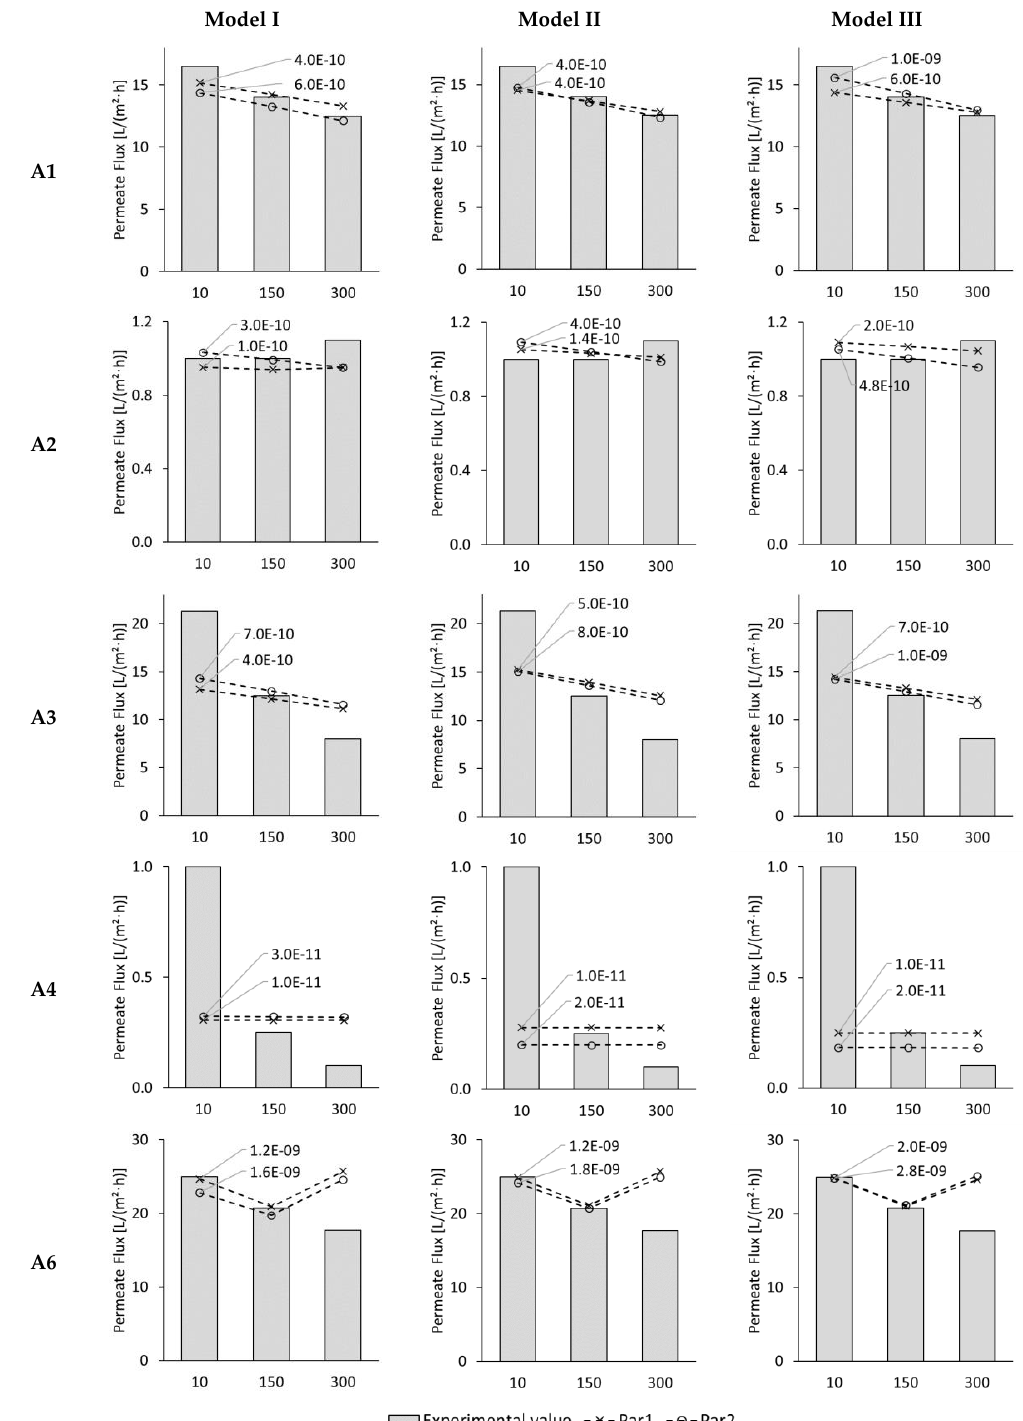
Figure 3. ALFS permeate fluxes of test series A1, A2, A3, A4, and A6 for 10, 150, and 300 min test time from experiments (columns) and Model I, Model II, and Model III with membrane parameter set Par1 (dashed line with crosses) and Par2 (dashed line with circles). Modelled results are shown for best-fitting diffusion coefficient which is indicated next to the corresponding line.